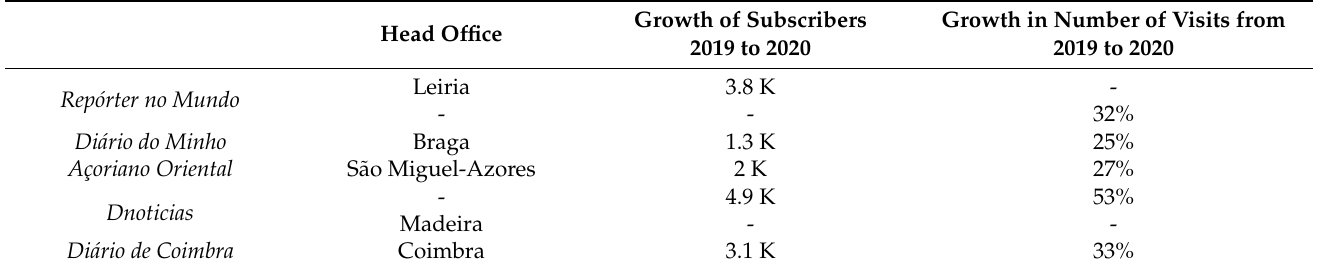
Table 3. Some data of the Portuguese local press apps